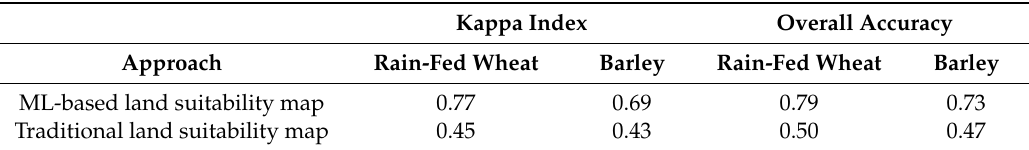
Table 5. Error criteria for comparing ML-based and traditional land suitability maps for the external validation based on random forest model.